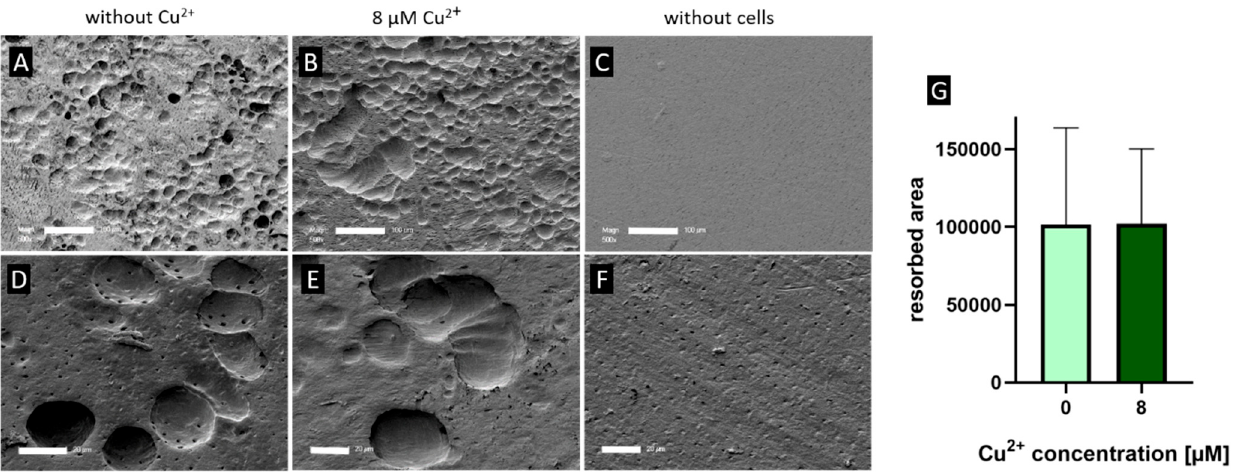
Figure 5. Representative SEM images of resorption pits after 14 days cultivation of PBMC derived osteoclasts on dentine slices ( A , D ) control, ( B , E ) 8 µM Cu 2+ , ( F , G ) without cells, scale bar represent 100 µm ( A – C ) and 20 µm ( D – F ). ( G ) Open source Fiji software was used to calculate resorbed area of dentin slices (cells of two PBMC donors, 24 images per group). For details see Supplemantary Figure S2. Mann-Whitney did not reveal significant differences between 0 and 8 µM Cu 2+ . In contrast, resorption of mineralized extracellular bone matrix was significantly reduced when osteoclasts were differentiated in the presence of Cu 2+ (Figure 6).